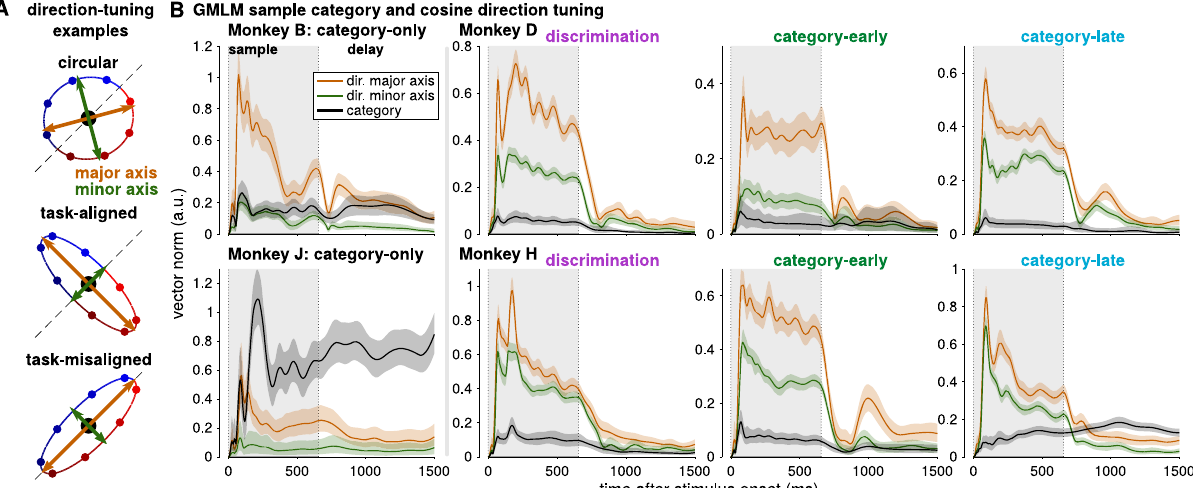
Fig. 7 | Quanti fi cation of category and direction encoding in LIP. A Diagram of direction encoding in the cosine-tuned GMLM. Motion stimulus direction is enco- ded as an ellipse in the low-dimensional stimulus space. The ellipse has major (orange arrows)andminor(greenarrows)axesthatde fi neitsshape.Iftheaxesare of similar length, tuning is approximately circular and the motion directions are evenly distributed in the low-dimensional space (top). If the major axis is elongate comparedtotheminoraxis,thepopulationshowsapreferreddirectionwhichmay be aligned with category (middle) or the null direction (bottom) or anywhere in between. Category is encoded as a vector in addition to the direction ellipse, and the category vector is constant for all motion directions within a category (in